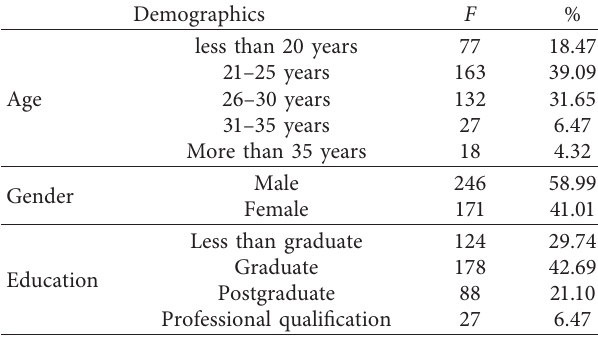
Figure 1: The conceptual framework. Table 1: Demographic profile of respondents ( N � 417 )